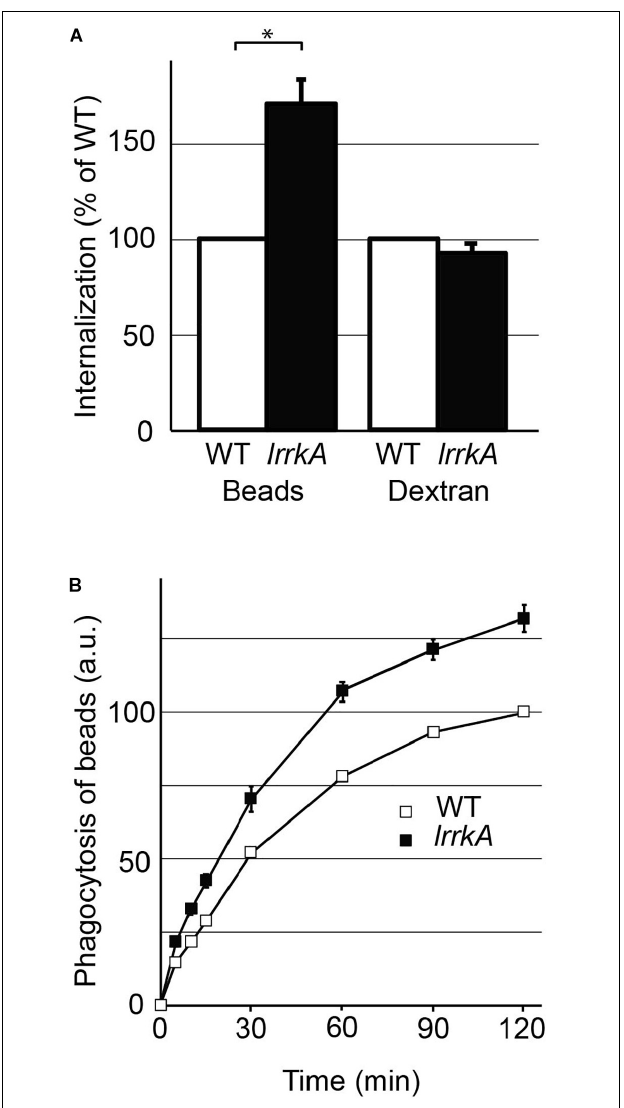
FIGURE 1 | Genetic inactivation of lrrkA stimulates phagocytosis. (A) D. discoideum cells (WT or lrrkA KO) were incubated for 20 min in HL5 medium containing either fluorescent polystyrene beads, or a fluorescent dextran. Internalization of beads or of dextran was measured by flow cytometry in seven independent experiments and averaged. Internalization by lrrkA KO cells was expressed as the percentage of internalization by WT cells in the same experiment (mean ± SEM, ∗ p < 0.01, Mann–Whitney test, N = 7 independent experiments). (B) D. discoideum cells (WT or lrrkA KO) were incubated for the indicated time in HL5 medium containing fluorescent polystyrene beads. The average and SEM at each time are indicated. LrrkA KO cells phagocytosed beads significantly more than WT cells at all times ( p < 0.01, N = 9, Mann–Whitney test).